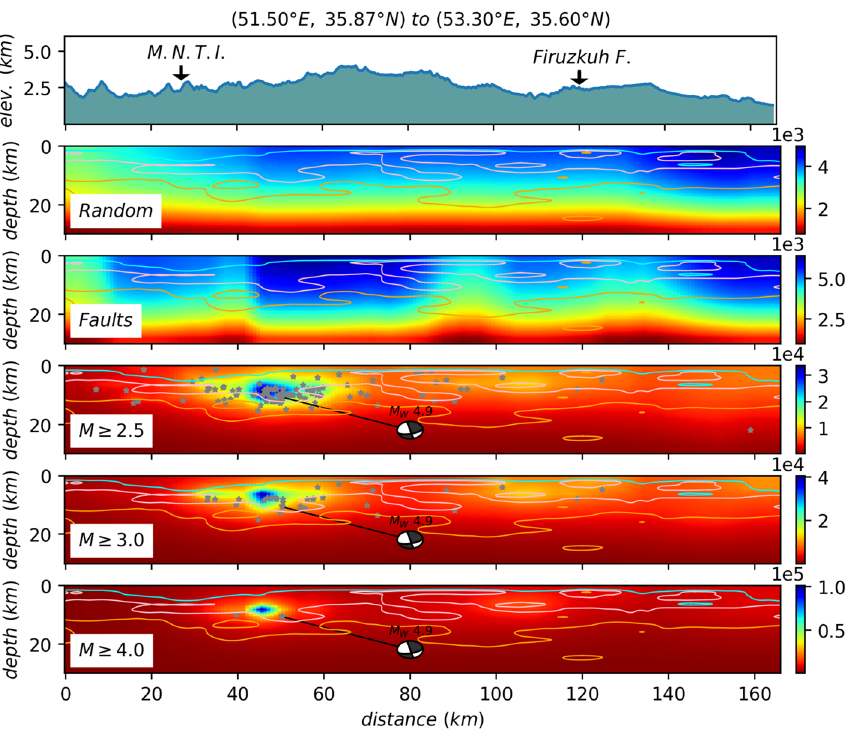
Figure 8. An activity field for the cross-section along (51.50°E, 35.87°N) to (53.30°E, 35.60°N) for the dynamics with avalanches in the whole space. All hypocenters of earthquakes within ±7 km distance from the profile are projected. The focal mechanism solution show an earthquake with M W 4.9 occurred at (52.05°E, 35.78°N, 7km) on May 7th, 2020 at 20:18:21.00 which was reported by IrSC. The solid cyan, pink, and orange contours represent the P-wave velocity of 5.8, 6.1, 6.3 kms −1 , respectively, calculated in Ref. 36 . The M.N.T.I abbreviation refers to the Mosha-North Tehran fault intersection (see Fig.